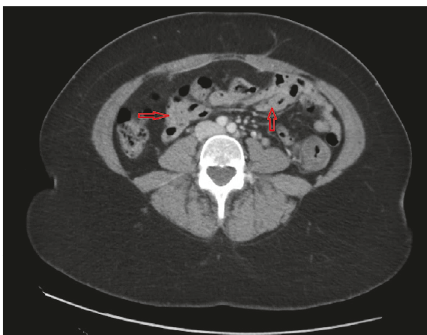
Figure 1: Transverse section of computed tomography scan demon- strating mild to moderate mural thickening of the descend- ing/sigmoid colon (arrows) consistent with colitis without peri- colonic abscess, ascites, or free air.